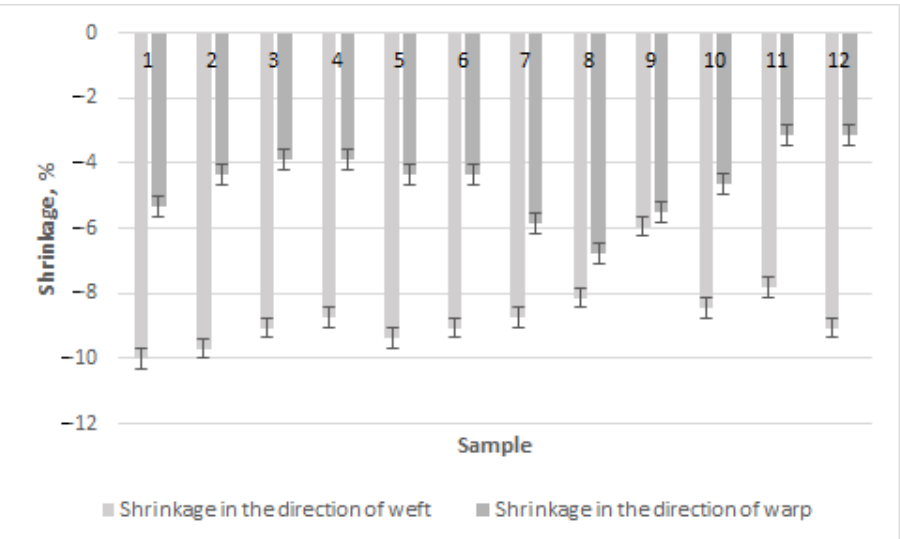
Figure 5. Shrinkage in the directions of the warp and weft of Series 2 fabrics.